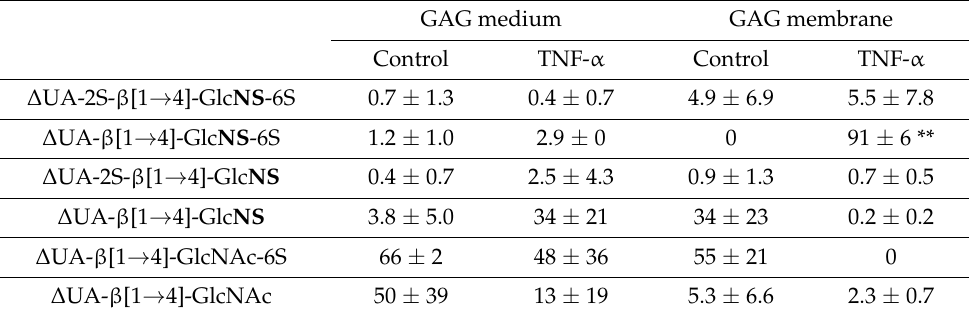
Table 1. HPLC analysis of the main HS/HE disaccharides. GAGs were isolated from plasma membrane and from culture medium of HUVEC control and TNF- α treated (24 h). To obtain HS/HE disaccharides, we digested GAGs with heparinases. After AMAC derivatization, the disaccharides were analyzed by means of HPLC. Data are expressed as % area of each HS disaccharide/ % area total. The N-sulfation in bold (NS) is catalyzed by NDST1. Values are mean ± SD of three independent experiments ** p < 0.01. UA: uronic acid; GlcNAc: N-acetyl; GlcNS: N-sulphonyl glucosamine: S: sulphate group [39].